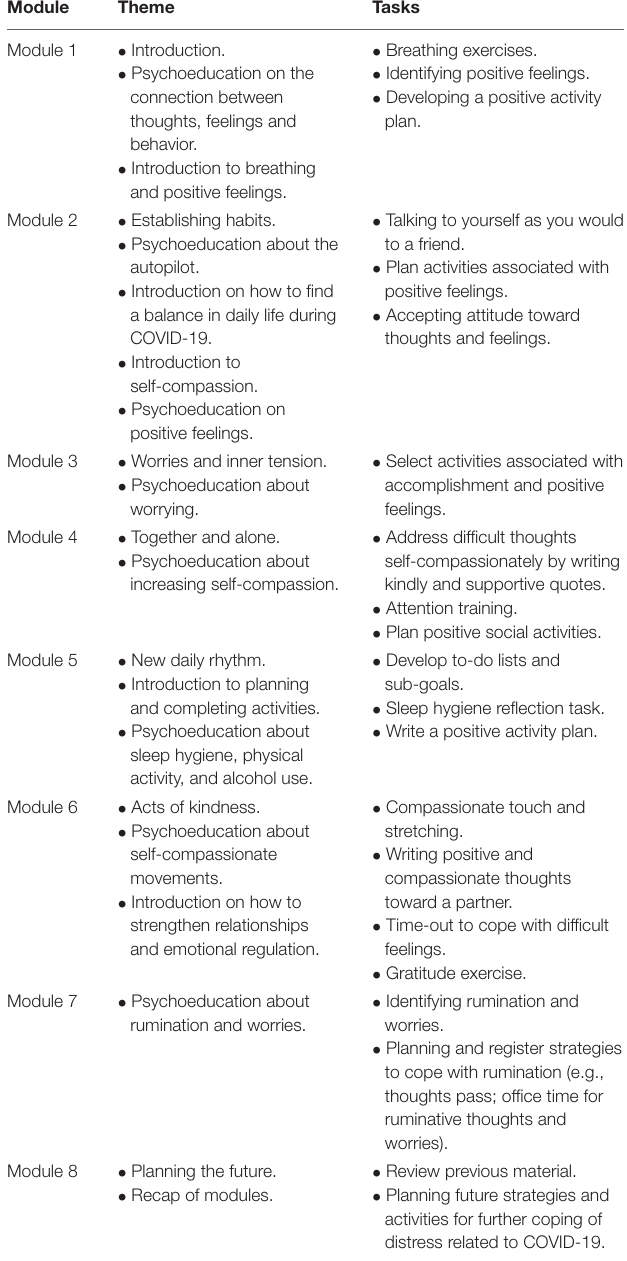
TABLE 2 | Overview of